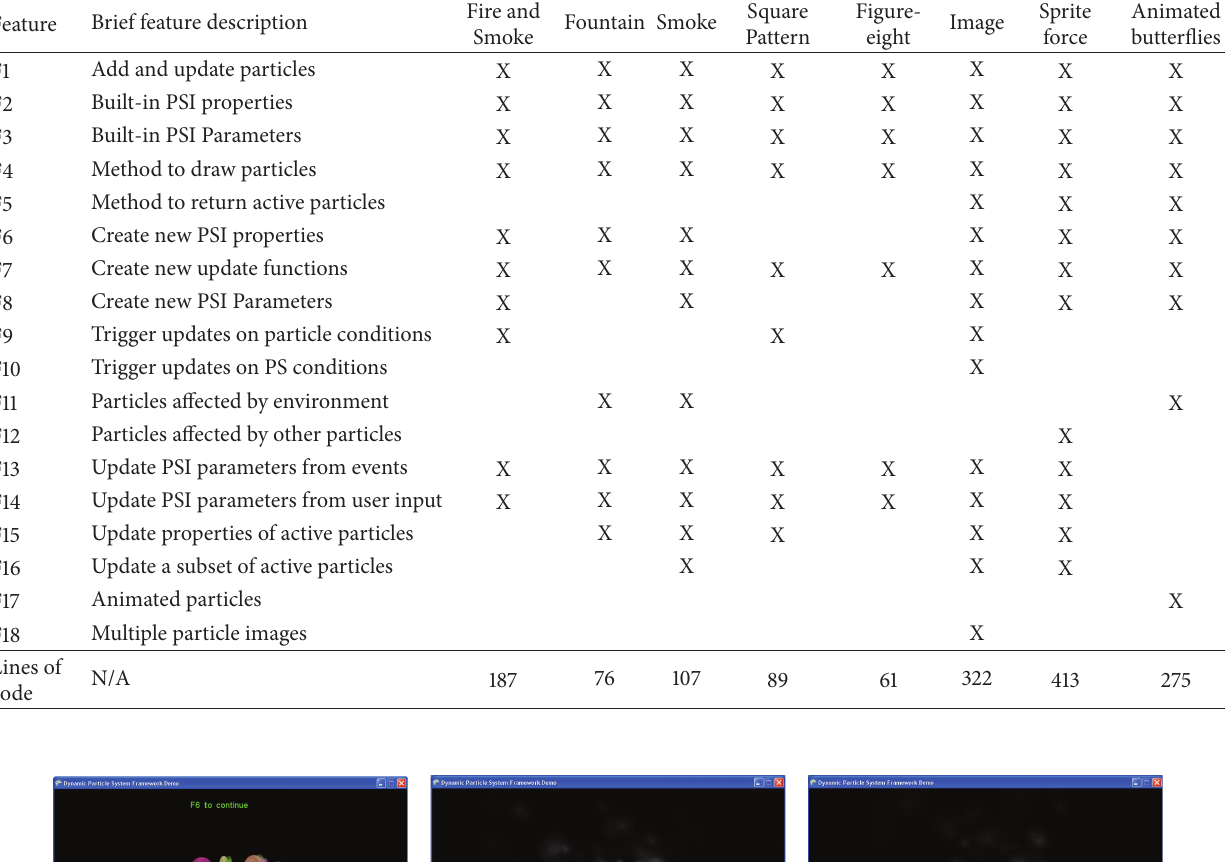
Table 2: Effects created in Demo, the features they demonstrate, and the number of lines of code used to create them. Feature